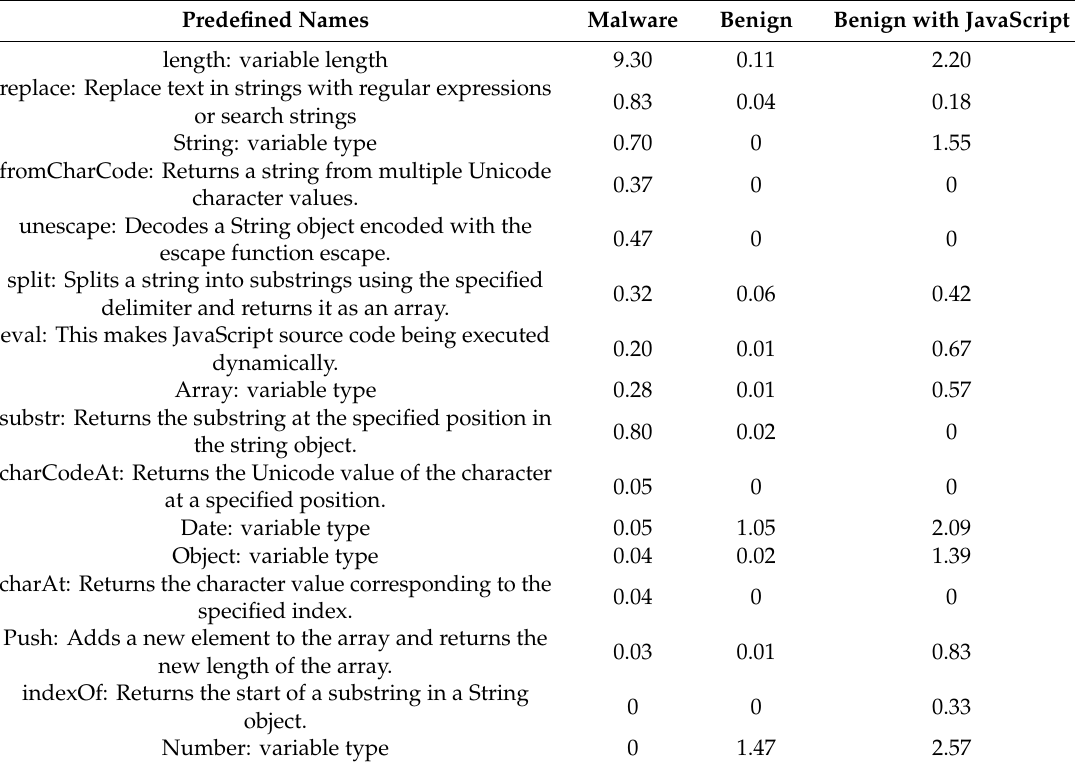
Table 3. The average count of names in